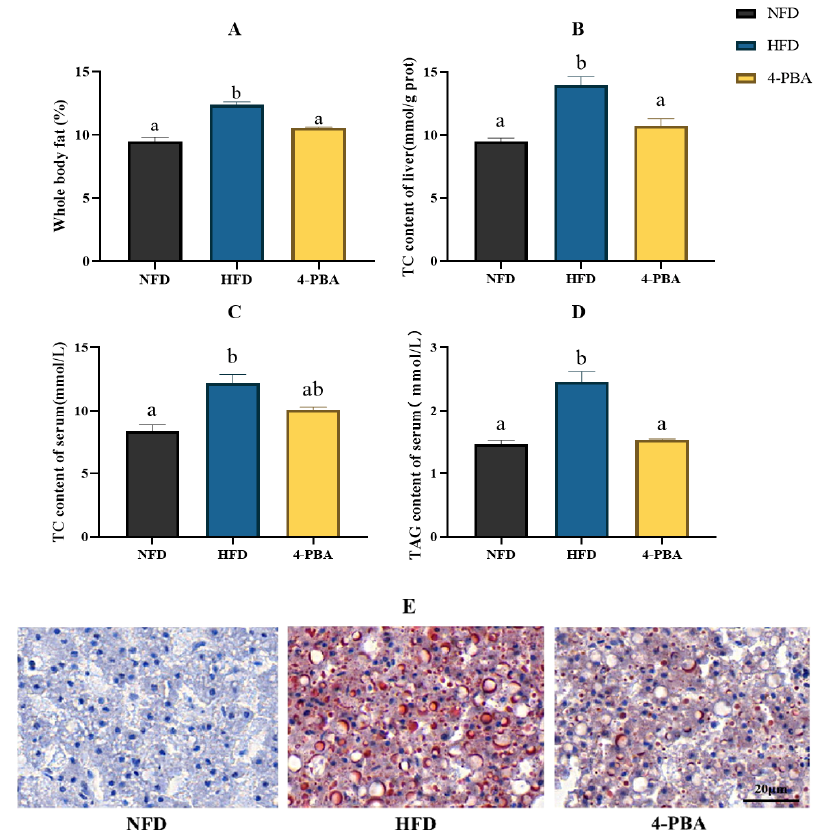
Figure 6. Experiment II. ( A ) Whole body fat. ( B ) Hepatic TC content. ( C ) Serum TC content. ( D ) Serum TAG content. ( E ) Liver oil red O-staining (( E ) scale bar = 20 μ m). All values are exhibited as mean ± SE ( n = 3). Different letters indicate a significant difference among groups ( p < 0.05, Tukey’s test, n = 3). Whole body fat = abdominal fat weight/whole body weight.